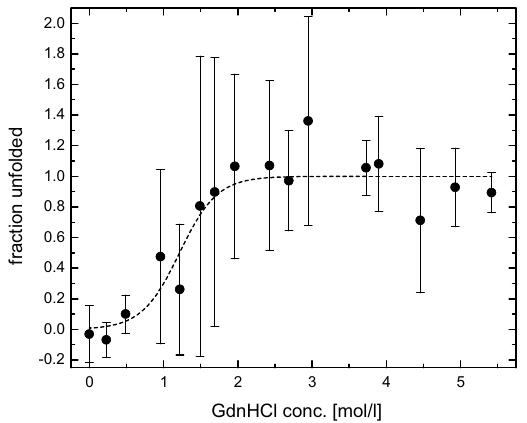
Figure 4. Unfolding curve of AF488-C(0)A β 42 from three independent 1fFCS and one 2fFCS measurement series with their corresponding best-fit line to the two-state unfolding model (equation (4)). Each data point is the average of at least three hydrodynamic radii, which were transformed into the fraction of denatured peptide according to equation (3). The error bars were calculated as the standard deviation between these independent measurements.